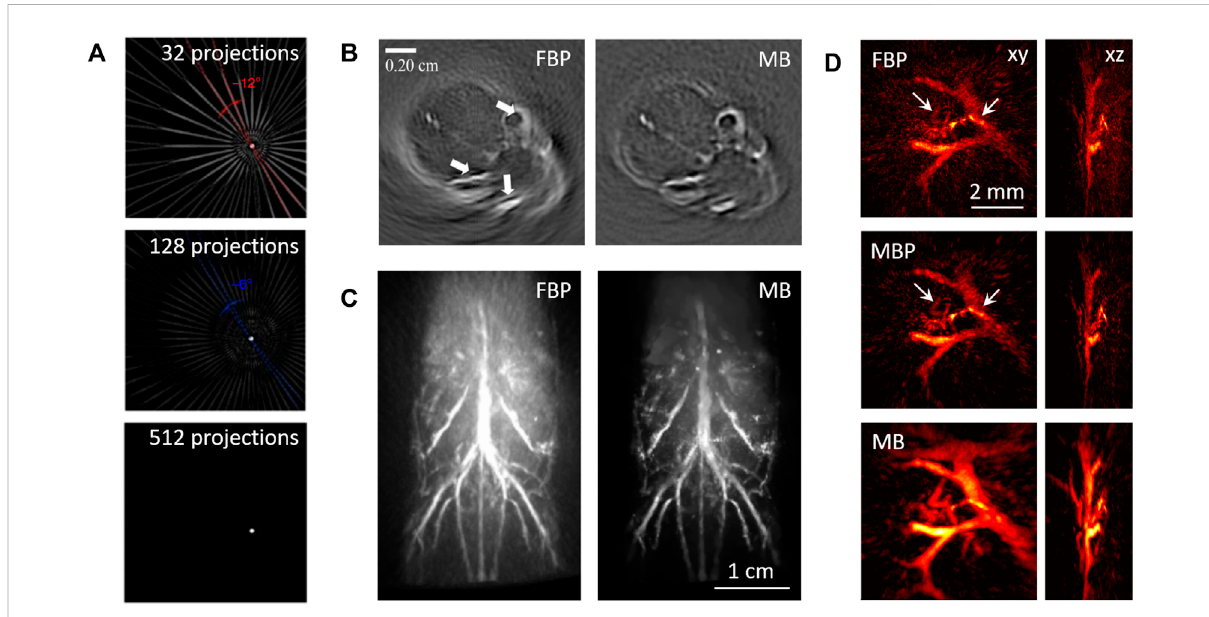
FIGURE 2 Performance comparison of model-based (MB) and fi ltered back-projection (FBP). (A) Example of streak-type artefacts produced in the reconstructed images as a function of the number of sensors considered. Adapted from [171] with permission from Nature Publishing Group. (B) Comparisonofthecross-sectionalimagesofthemousebrainrenderedwithFBPandMB.Adaptedfrom[86]withpermissionfromAmericanInstitute of Physics. (C) Comparison of the three-dimensional full-wave images reconstructed with FBP and MB based on total-variation regularization. Adapted from [48] with permission from Institute of Physics. (D) Comparison of the three-dimensional images of the fi nger vasculature of a healthy volunteer obtained with FBP, model back-projection (MBP) and MB based on Tikhonov regularization. Reprinted from [55] with permission from Institute of Electrical and Electronics Engineers.